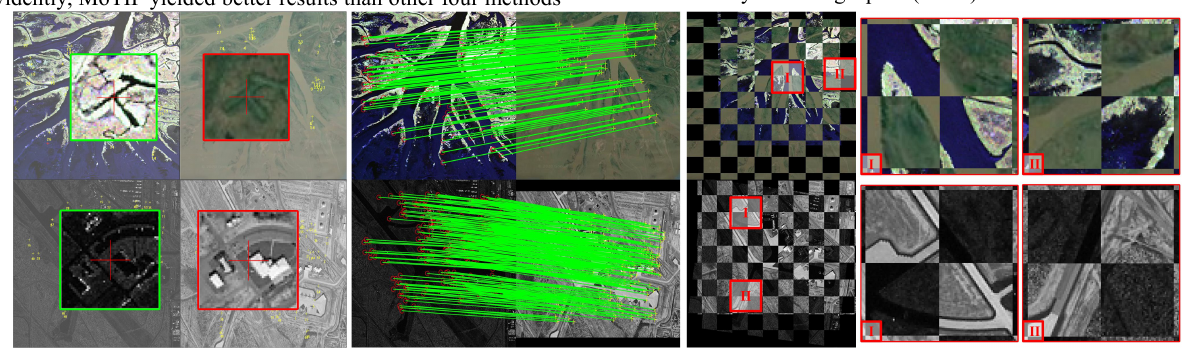
Figure 5 . Matching and registration results of SAR-optical